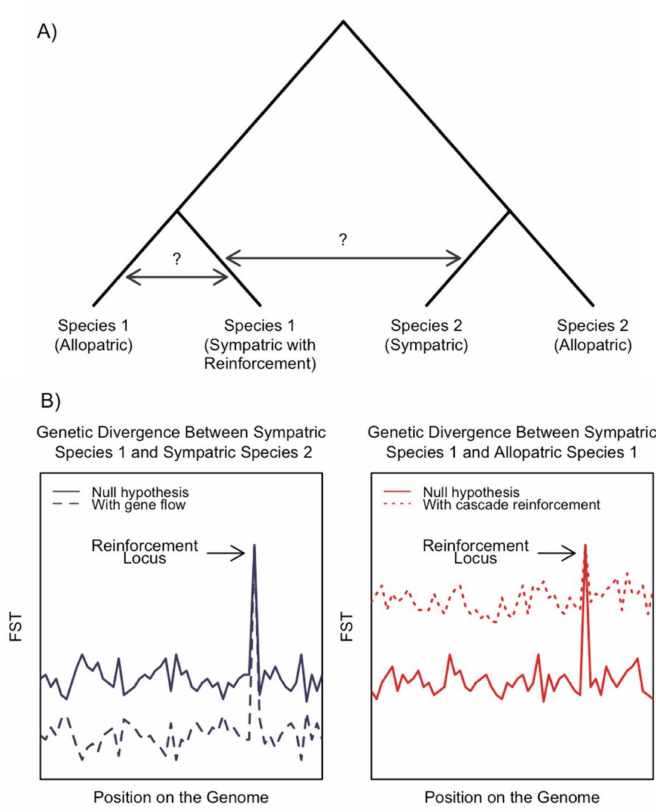
Figure 3. Gene flow affects the evolution of reinforcement ( a ) a phylogenetic network analysis of two species with sympatric and allopatric populations can allow for the identification of the direction and quantity of gene flow between the lineages. ( b ) Hypothetical examples of how gene flow, or the lack thereof, may impact genome-wide divergence between sympatric species. ( Left ) Gene flow between sympatric species (dashed) will decrease genome-wide genetic divergence, making identification of the reinforcement locus easier. ( Right ) Hypothetical example of how a lack of gene flow between allopatric and sympatric populations within a species impacts identification of reinforcement loci. Over time, cascade reinforcement (dotted) may increase the amount of genetic divergence observed between the allopatric and sympatric populations, making identification of the reinforcement locus more